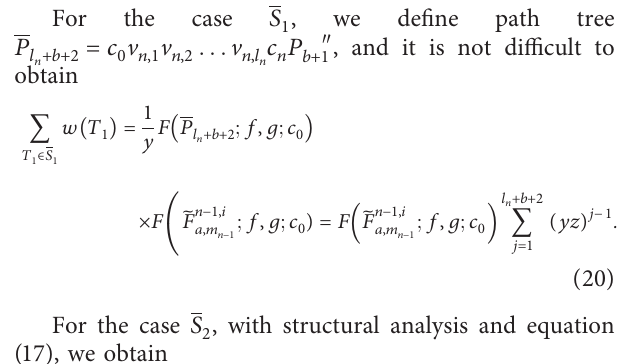
( i � 1 , 2 , 3 , 4 ) . (a) 􏽥 F 4 , 1 1 , 1